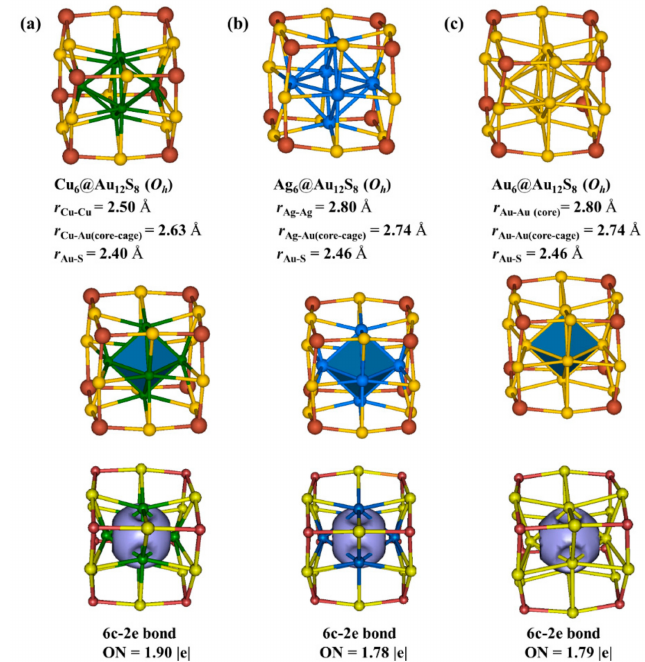
Figure 7. Structures, superatom models and AdNDP localized natural bonding orbitals of 6c-2e bonds in ( a ) Cu 6 @Au 12 ( µ 3 -S) 8 , ( b ) Ag 6 @Au 12 ( µ 3 -S) 8 , and ( c ) Au 6 @Au 12 ( µ 3 -S) 8 clusters. Cu, green; Ag, blue; Au, yellow; S,